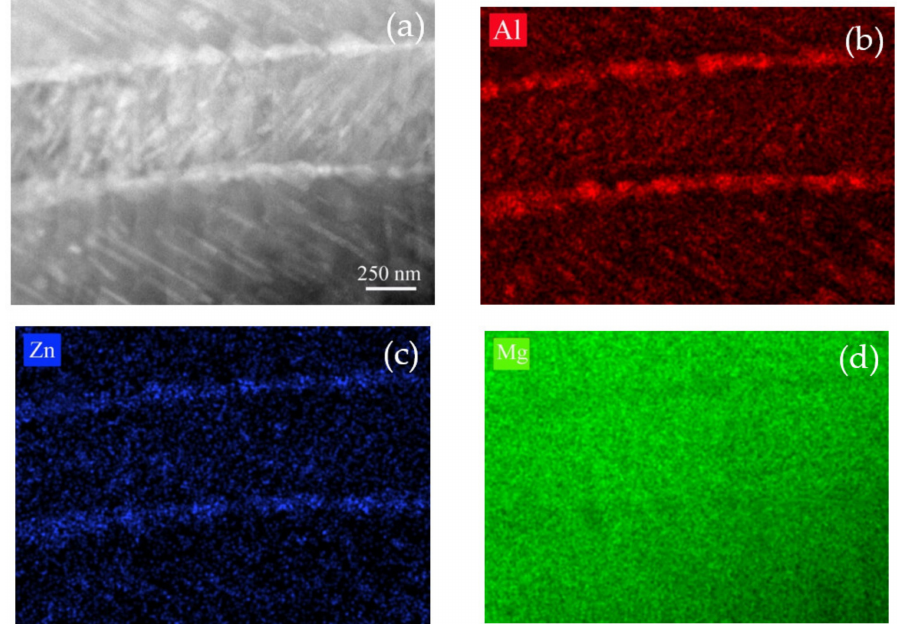
Figure 9. ( a ) TEM picture taken in the sample subjected to 175 MPa and then aged at 170 ◦ C for 3 h, ( b – d ) Corresponding EDS maps highlighting the Al, Zn and Mg elements.